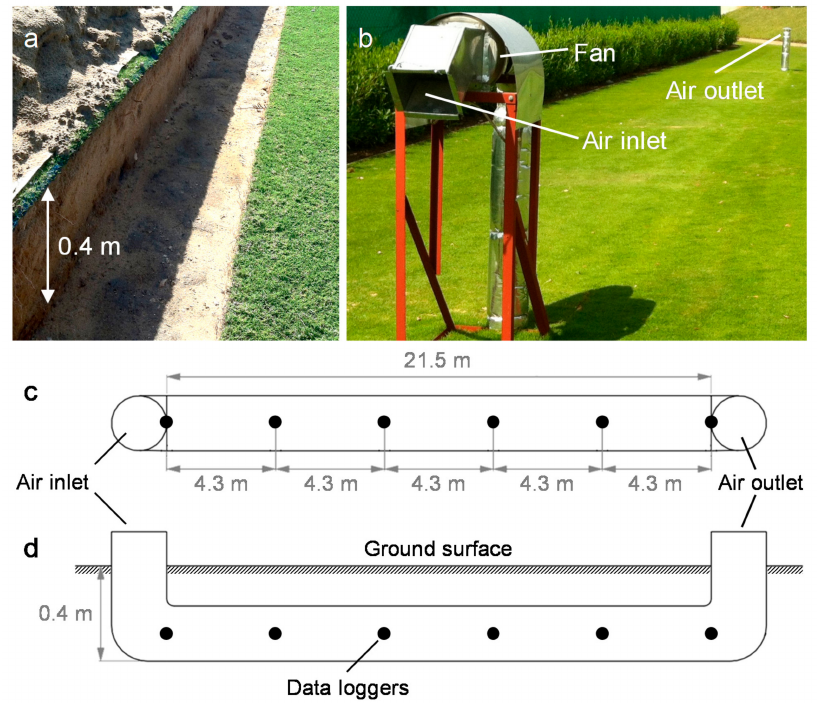
Figure 1. ( a ) Picture of the trench where the EAHE tube was buried. ( b ) Picture of the assembled EAHE. ( c ) Schematics of the top view and ( d ) side view of the EAHE showing the measurement